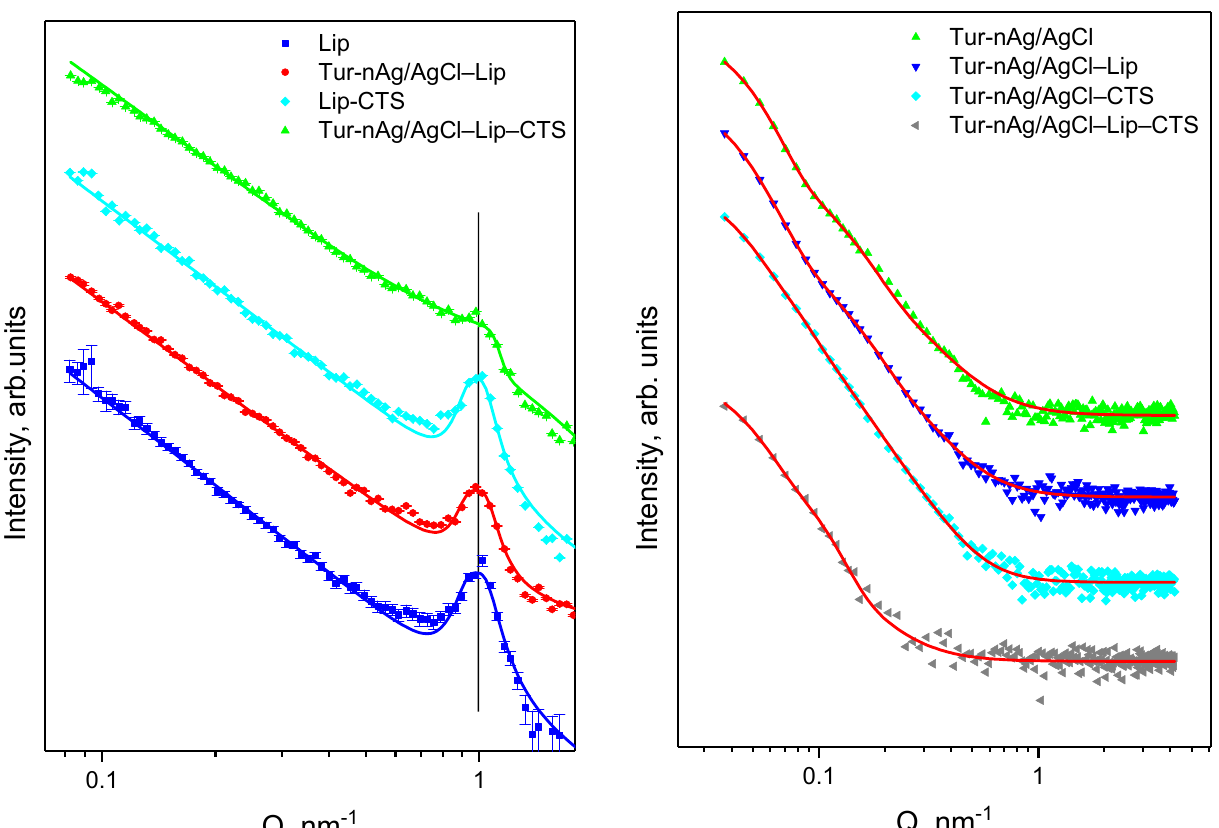
Figure 3. SANS ( left ) and SAXS ( right ) curves for samples in excess PBS medium. Symbols are experimental data and lines are fits. For better clarity, the curves are spaced relative to each other by a factor of 10 on the intensity scale from bottom to top.